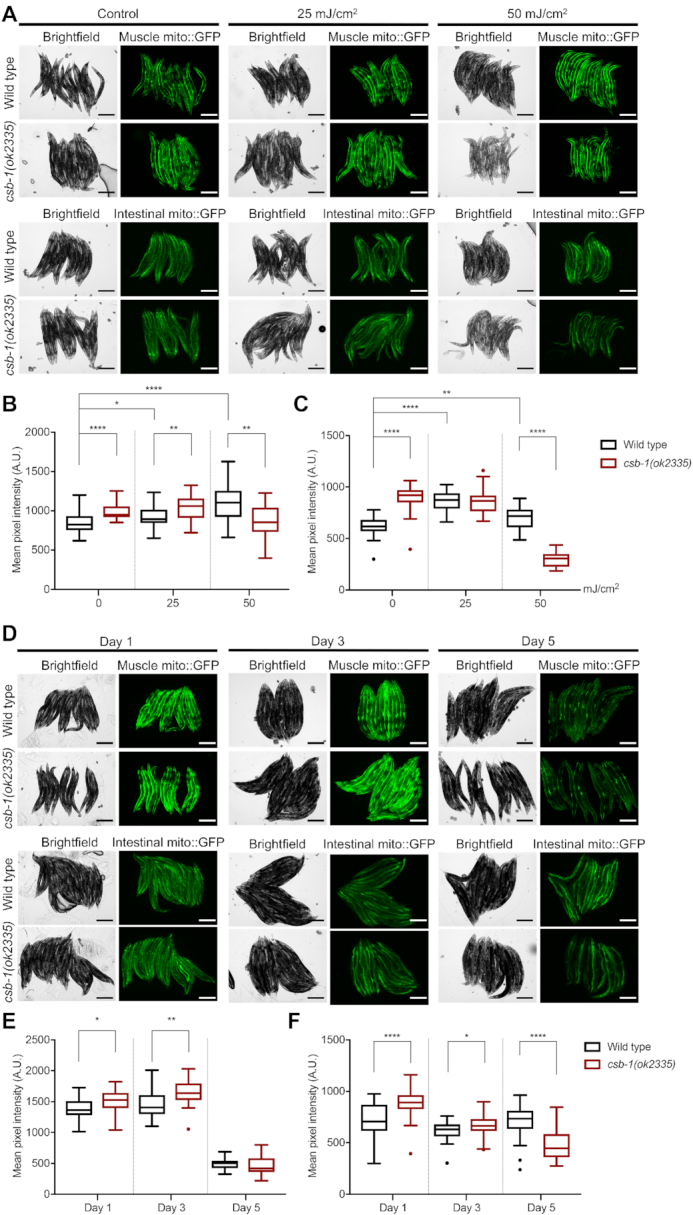
Mitochondrial mass accumulates in csb-1 mutants. (A) Representative images of animals expressing muscular (pmyo-3mito::GFP, upper panel) or intestinal (pges-1mito::GFP, lower panel) mitochondrial localized GFP upon UVB irradiation. The brightfield images and the corresponding fluorescence images are shown. (B) Quantification of pmyo-3mito::GFP. (C) Quantification of pges-1mito::GFP. (n = 25 animals). Whiskers in (B) and (C) show the SD. (n = 25 animals). Statistics were computed with the non-parametric Mann–Whitney test with *P < 0.05, **P < 0.01, ***P < 0.001 and ****P < 0.0001 and Tukey outliers are shown. (D) Representative images of animals expressing muscular (pmyo-3mito::GFP, upper panel) or intestinal (pges-1mito::GFP, lower panel) GFP in mitochondria during adult ageing. The brightfield images and the corresponding fluorescence images are shown. (E) Quantification of pmyo-3mito::GFP. (F) Quantification of pges-1mito::GFP. Error bars in (E) and (F) show the SD (n = 25 animals). Statistics were computed with the non-parametric Mann–Whitney test with *P < 0.05, **P < 0.01, ***P < 0.001 and ****P < 0.0001 and Tukey outliers are shown. Size bars in (A) and (D) are 250 μm.